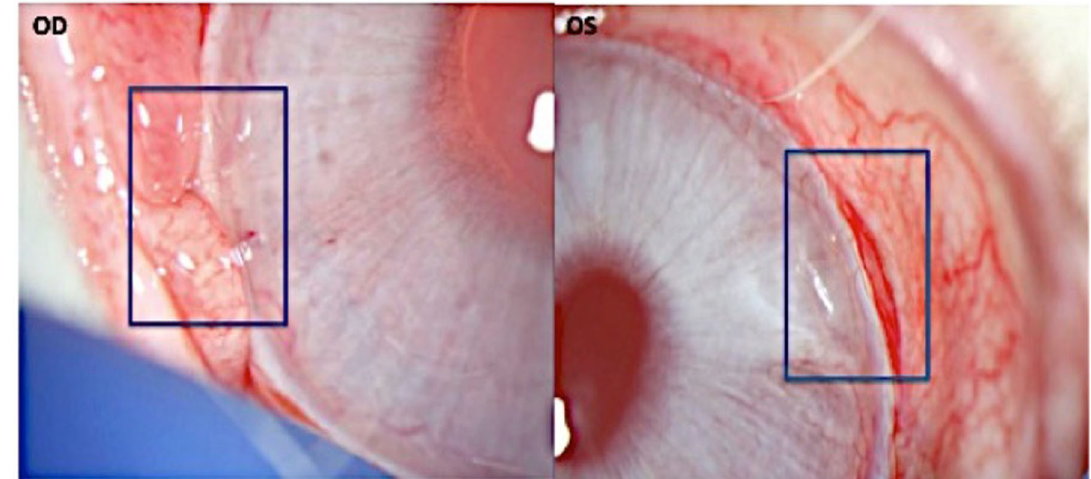
Fig. 2 Slit lamp exam photos from day 180 from Group 2 with implanted VisiPlate in the right eye (OD) treated with MMC and the left eye (OS) without MMC. Minimal in fl ammation was visible with appropriate placement of VisiPlate maintained in the subconjunctival